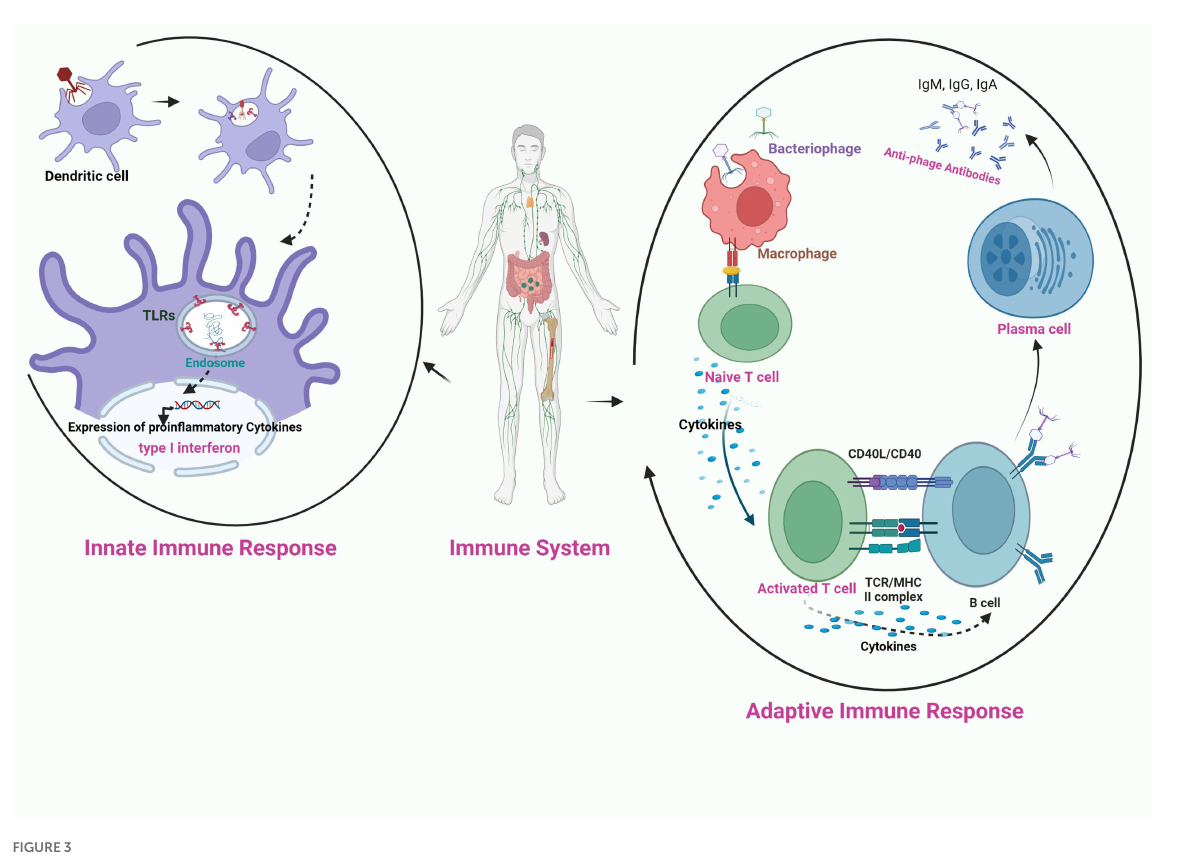
FIGURE 3 Schematic illustration of the interaction of bacteriophage nucleic acid with the toll like receptors (TLR) present on the endosome of phagocytic cell (innate immune response), activation of pro-inflammatory cytokines and production of anti-phage antibodies through the activation of adaptive immune response on exposure of phage to APC (antigen presenting